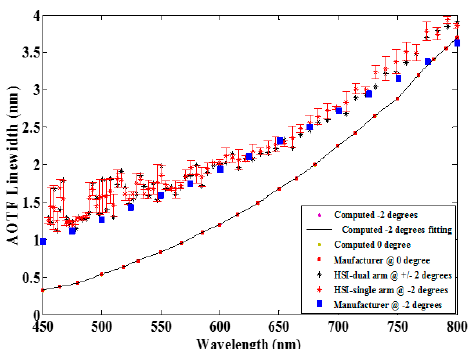
Figure 3. The AOTF-HSI imaging spectrometer line-width (FWHM—full width half maximum) for both single arm and dual arms, compared with the manufacturer line-width data in addition to a theoretical computational data for different optical input incident at angles (0, ±2 degrees). The standard deviation is computed for each arm in the developed AOTF-HSI system and plotted as error bars for the single arm curve.